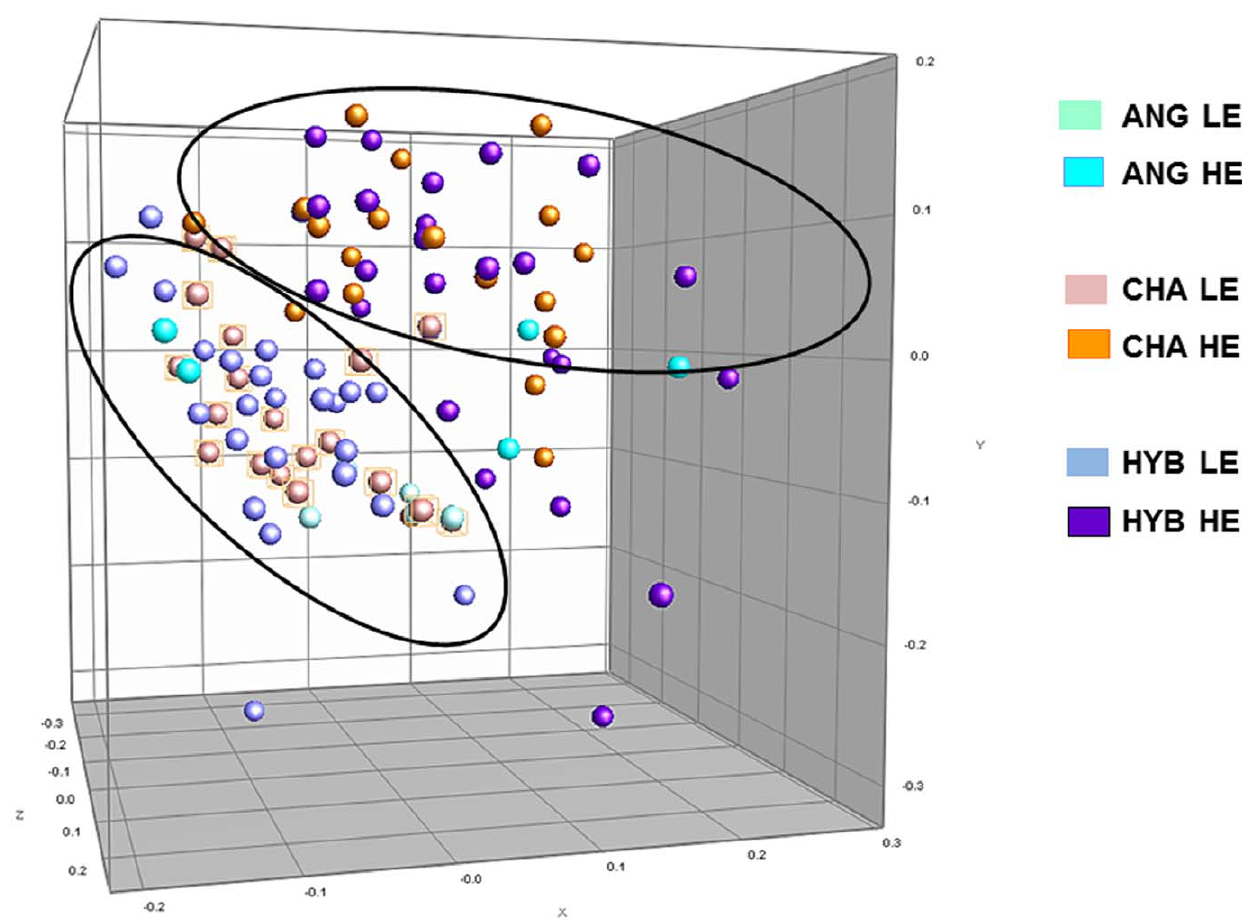
Figure 1. Multidimensional Scaling Analysis of the bacterial profiles generated from the rumen fluid of 49 steers, progeny of ANG, CHA or HYB sires. DNA from forty-nine steers fed low energy (LE) density diet and then switched to high energy (HE) density diet, was amplified using primers HDA1-GC and HDA2 (22 to 55% DGGE). Colours represent a particular sire breed: light blue, ANG fed LE diet; cyan blue, ANG fed HE diet; light pink, CHA fed LE diet; orange, CHA fed HE diet; azure blue, HYB fed LE diet, and purple, HYB fed HE diet. The comparison of the PCR-DGGE profiles was generated with the Bionumerics software package using UPGMA (unweighted pair-group) method as described in the text; comparison was optimised upon calculation of the best values for tolerance. each column of the contingency tables obtained with PROC was a cloud of profile points representing phylotypes, which values add up to 1. These points have a centroid (i.e., the average value of points. Each profile point contributes to the deviation from the